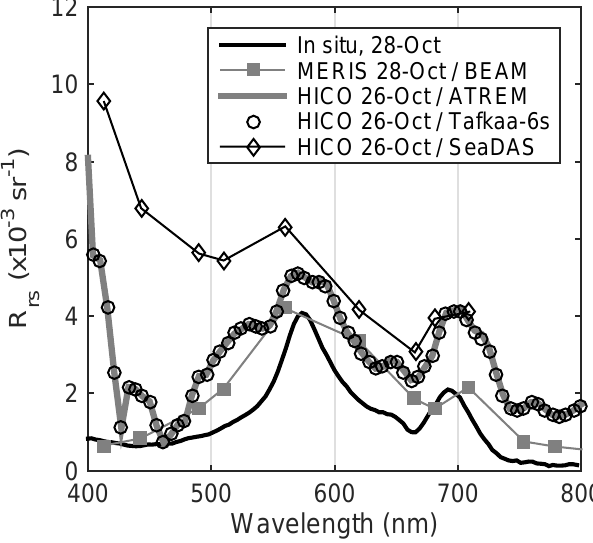
Figure 9. (Revised). Fall 2011 study: Ground truth optical measurements acquired along the periphery of a red tide patch on 28 October 2011 (location shown in Figure